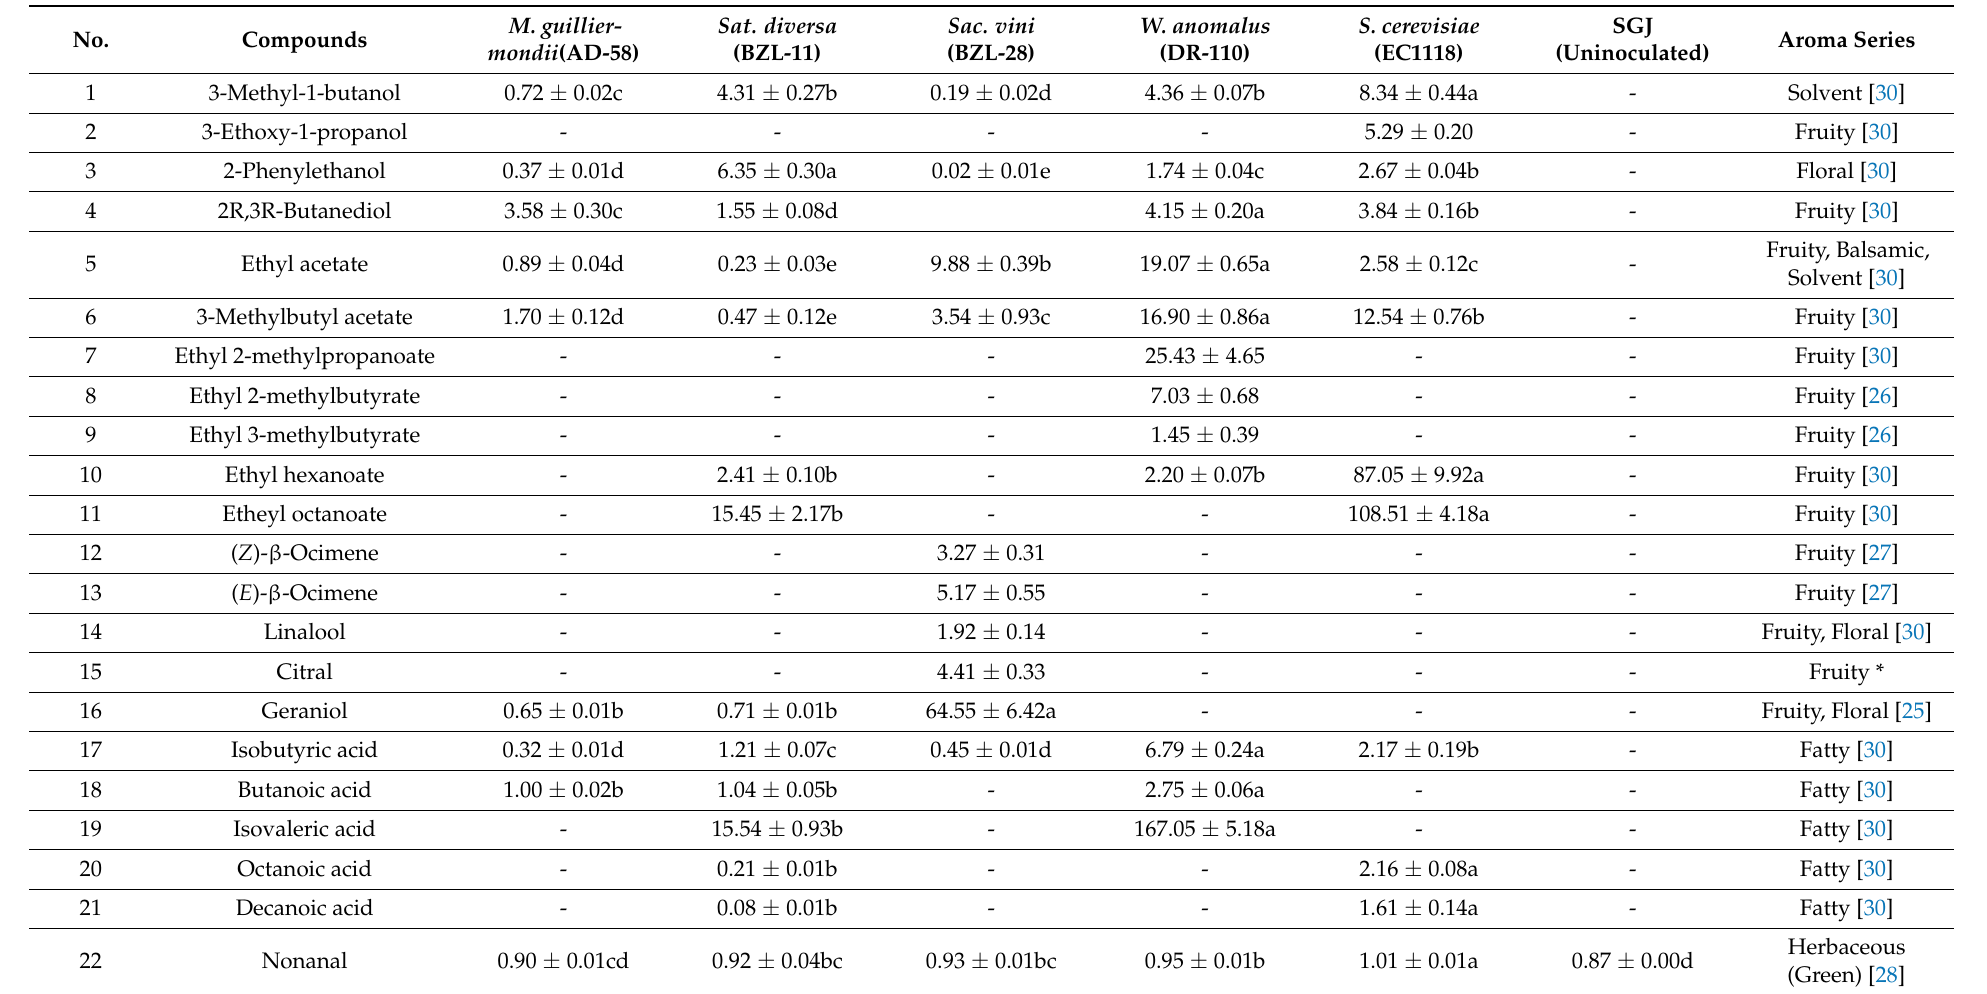
Table 3. OAVs of key aroma compounds in five fermented media and